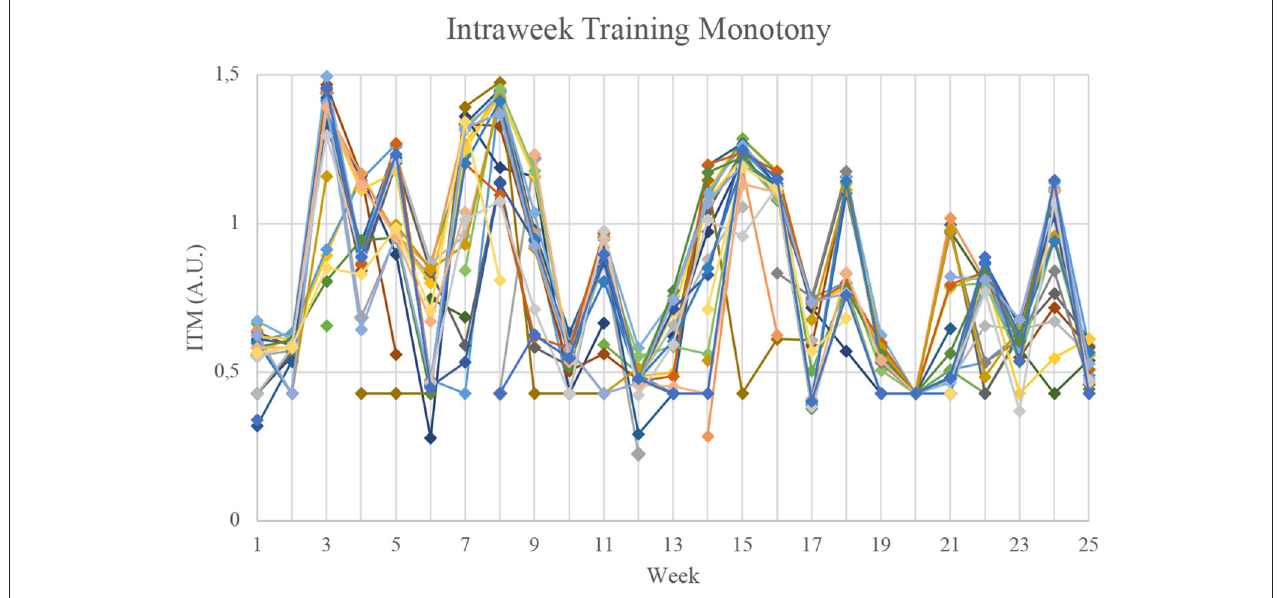
FIGURE 5 | Individual values for Intraweek Training Monotony. A.U., Arbitrary units.